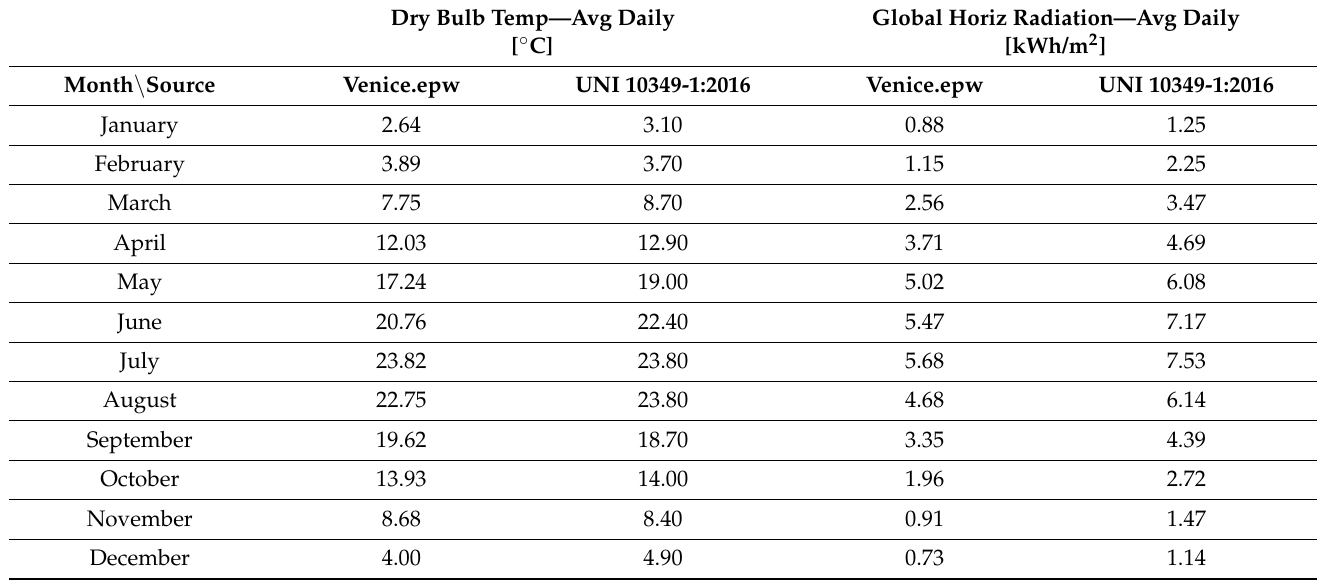
Table 2. Weather data